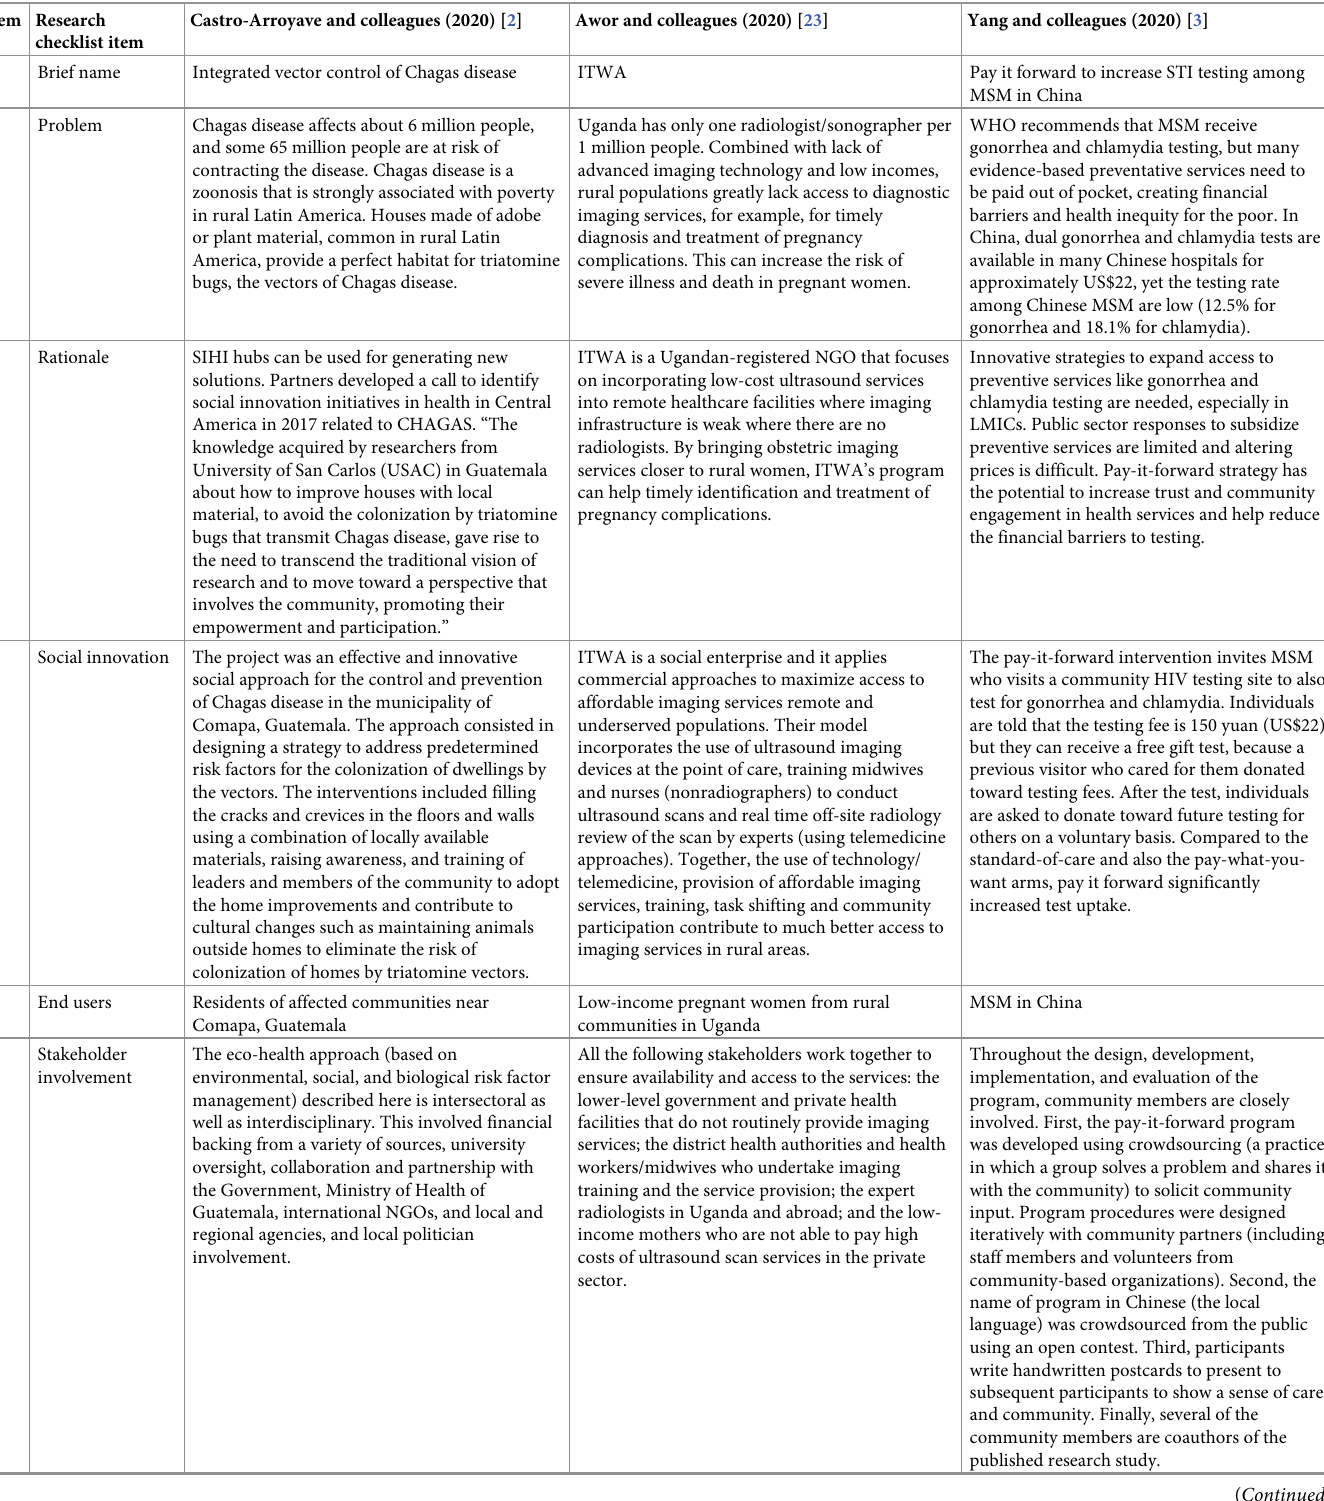
Table 3. Examples of social innovations in health described using SIFHR Checklist. Item Research checklist